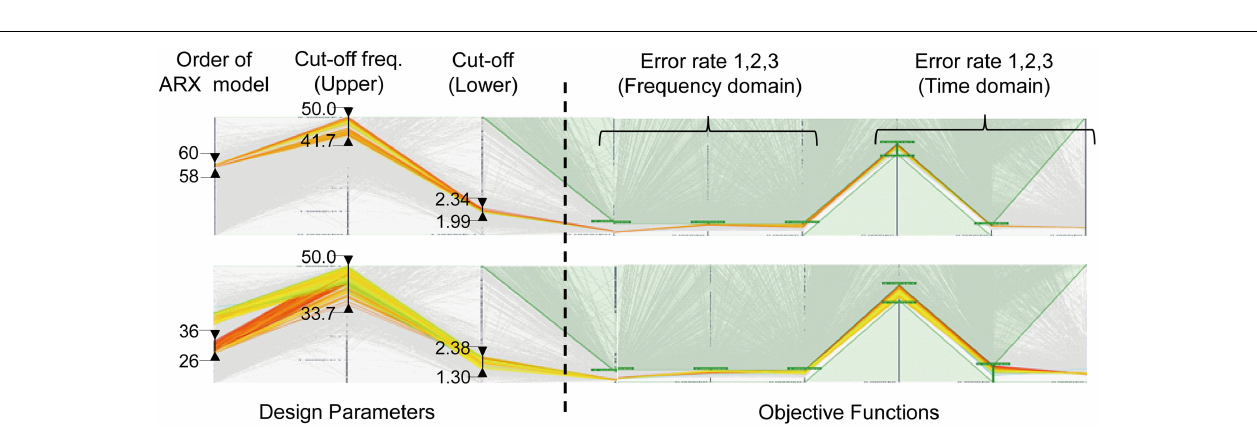
Frontiers in Built Environment |